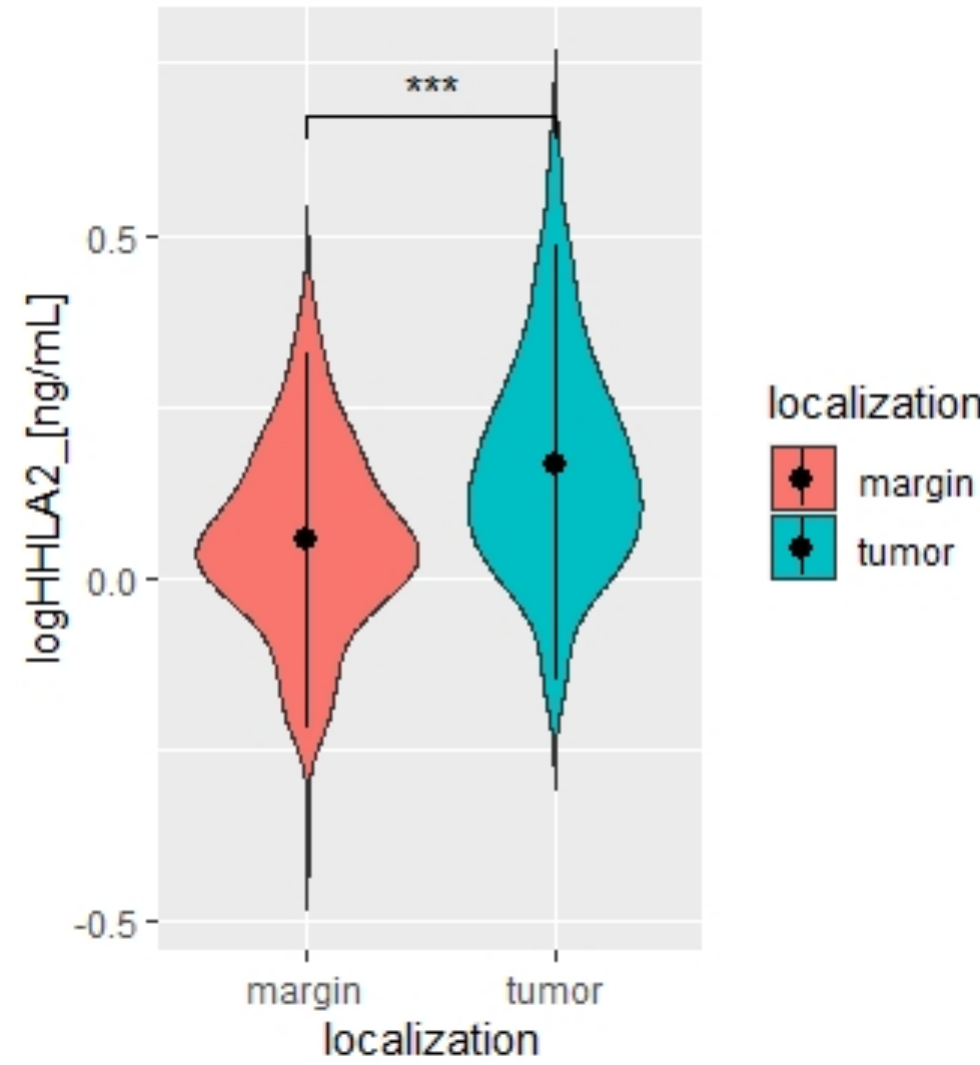
Figure 1. Violin plot of HHLA2 concentrations in tumor and margin tissue [ng/mL], N = 167. Paired T-test. *** p < 0.0001.